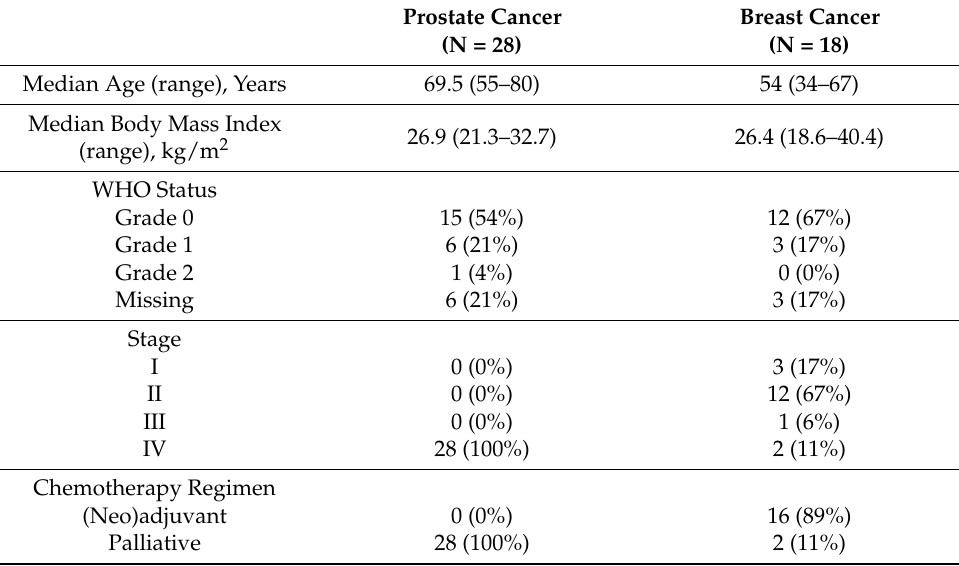
Table 2. Patient